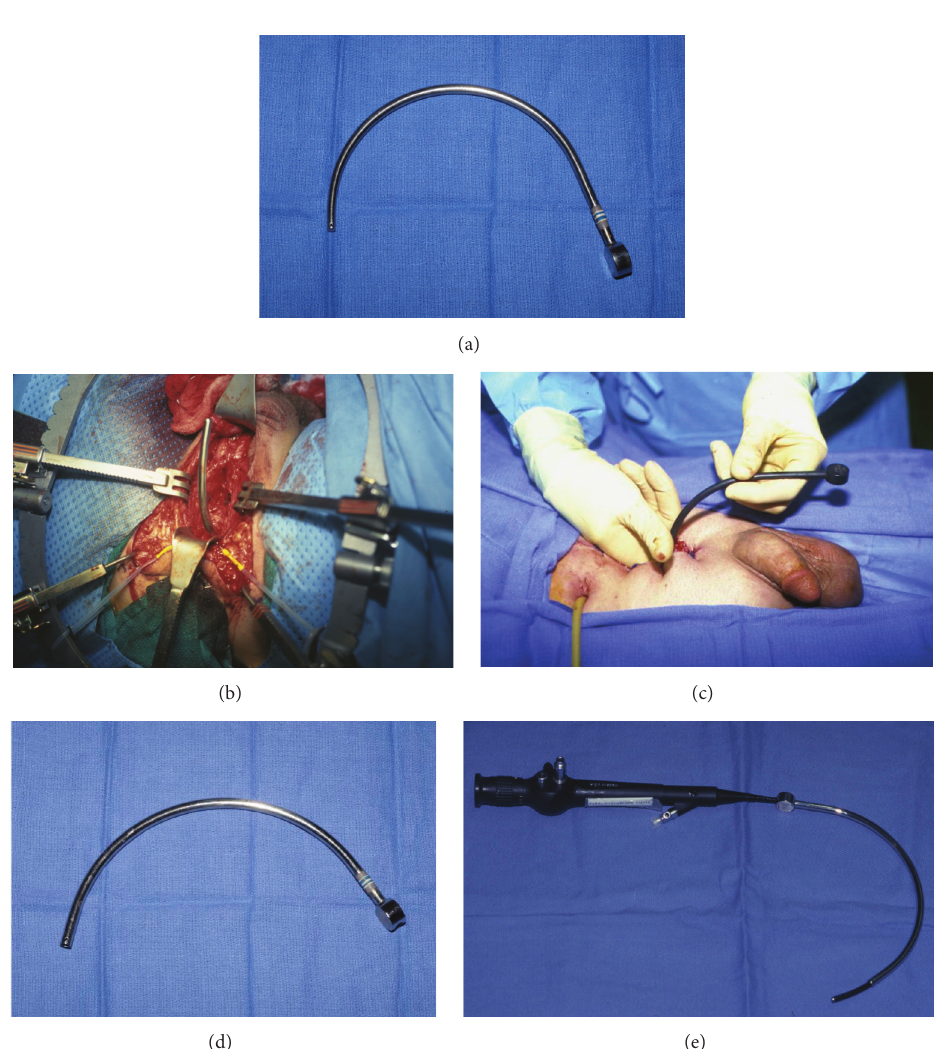
Figure 9: (a) Solid Haygrove sound. (b) After dissection of the obliterative scar, the tip of the sound (placed through the suprapubic tract) can then be advanced through the patent proximal urethra into the perineum. (c) Temporary vesicostomy in a patient with a laterally placed suprapubic tube. (d) Gelman visualizing posterior urethral sound. (e) Flexible scope advanced through the hollow visualizing